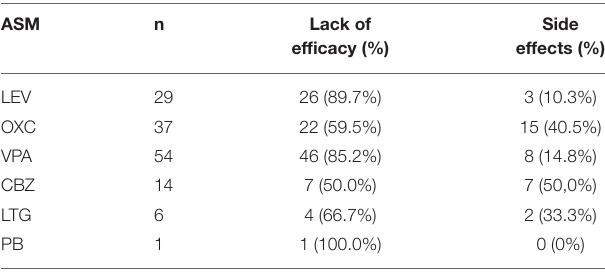
TABLE 3 | Reasons and proportion of treatment failure with the first ASMs.